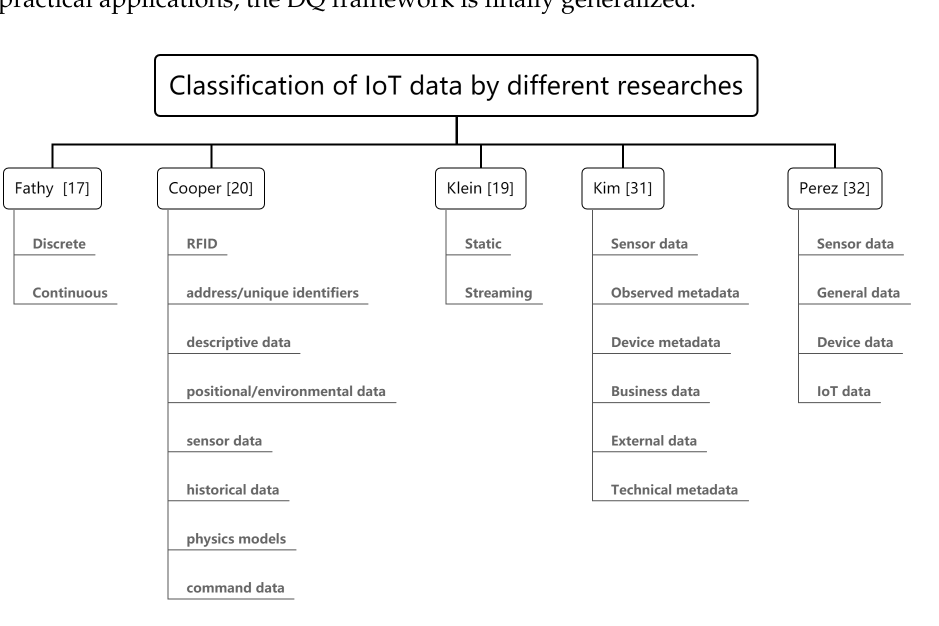
Figure 1. Classification of IoT data by different